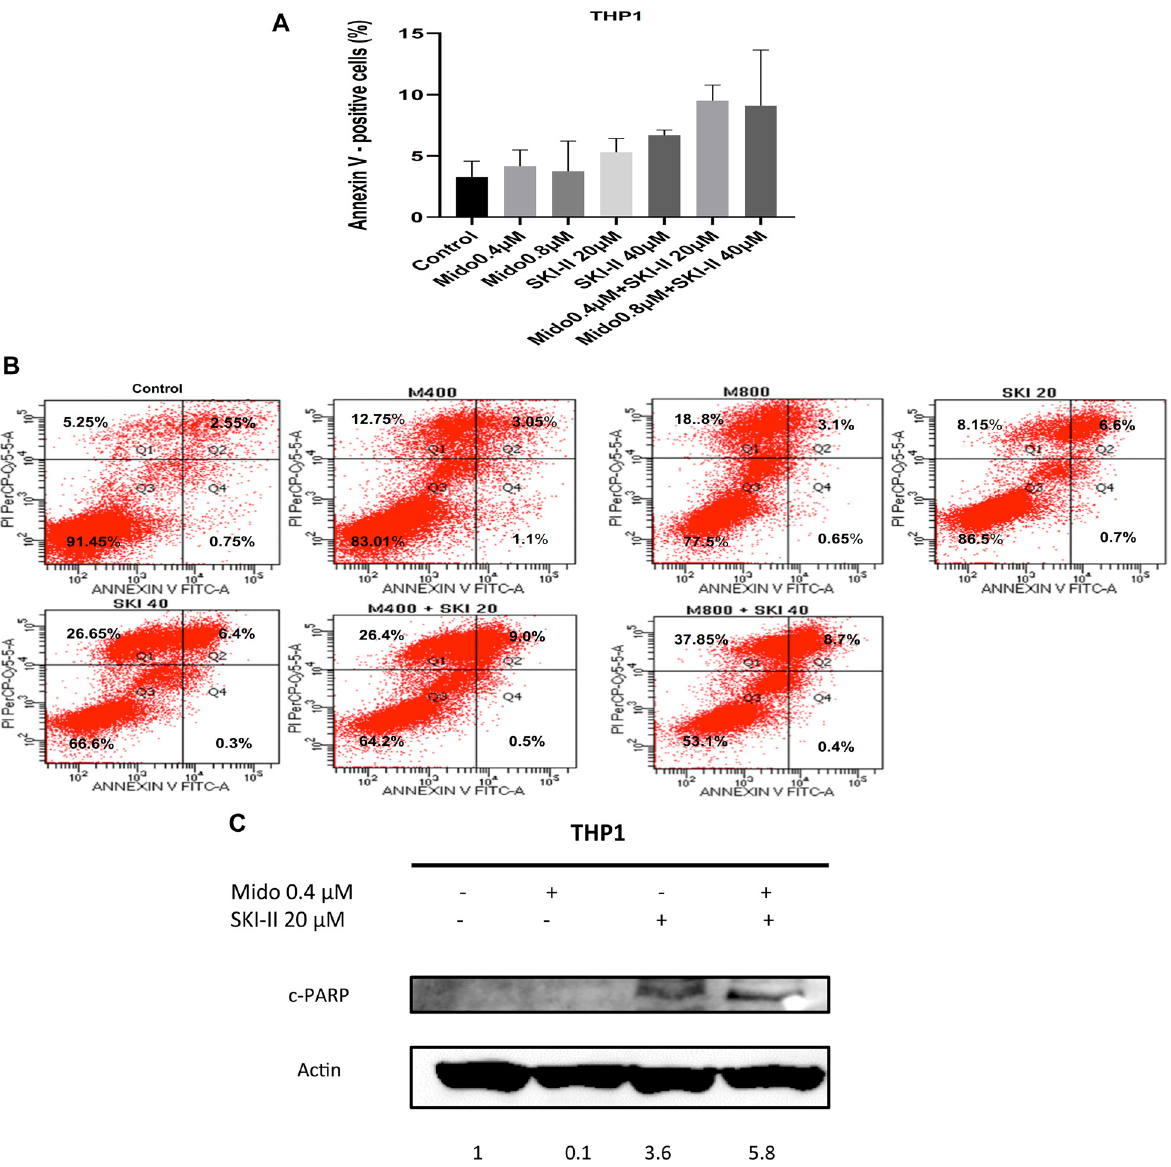
Figure 4: Apoptotic effects of midostaurin, SKI II and combinations on THP1 cells. The results derived from the means of at least two independent experiments are represented as mean ± SD. The percentage of annexinv-positive/PI negative early apoptotic population and annexinv-positive/PI positive late apoptotic population were calculated and normalized to untreated control or each agent alone (A) and (B). PARP cleavage in response to midostaurin, SKI II and the combination